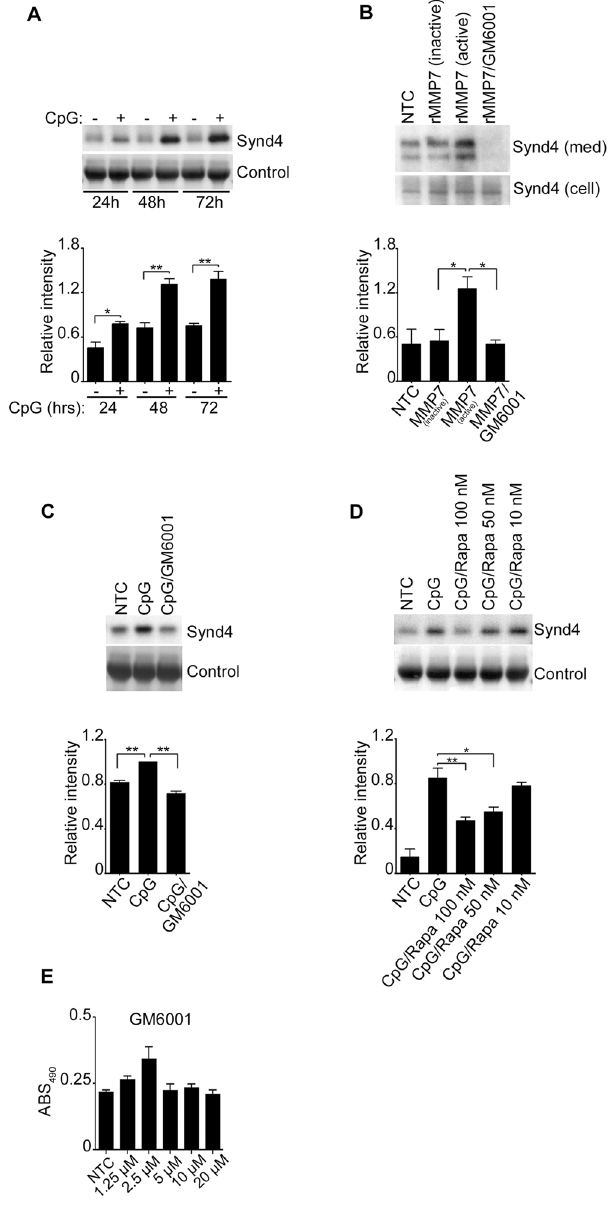
Figure 8. MMP7 mediates the shedding of Syndecan-4 in activated B-lymphocytes. Syndecan-4 was detected by immunoblotting in the cell supernatant after CpG-stimulation for the indicated periods of time ( A ); after incubation with (5 μ g/ml) recombinant active and inactive MMP-7 in the presence or absence of (5 μ M) MMP-7 inhibitor (GM6001) for 6 hours ( B ); after CpG-stimulation in the presence or absence of GM6001 ( C ) ; and after CpG-stimulation in the presence of different concentrations of Rapamycin ( D ). Densitometric levels were obtained using ImageJ software and relative protein intensities were normalized against that of loading control. ( E ) Cells were incubated with GM6001 at different concentrations as indicated. XTT was measured after 24 hours. Data are representative of at least three replicate experiments. * p < 0.01, ** p <